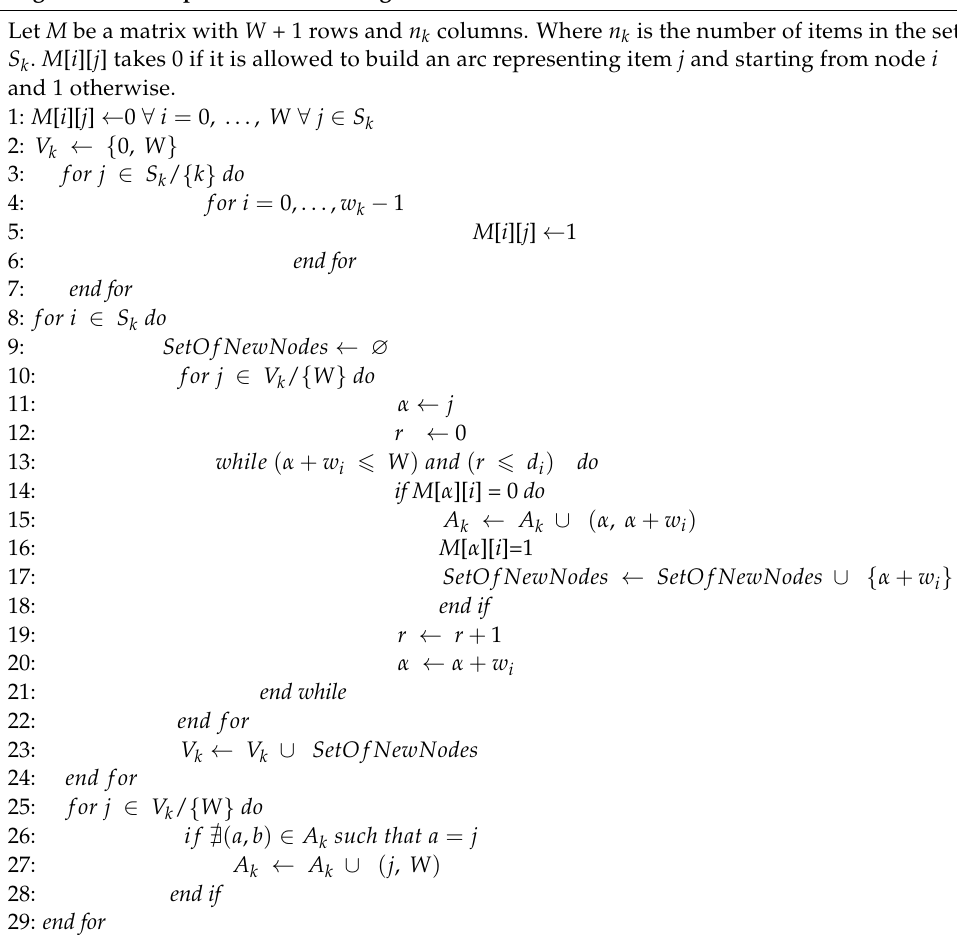
Algorithm 1. Graph Construction